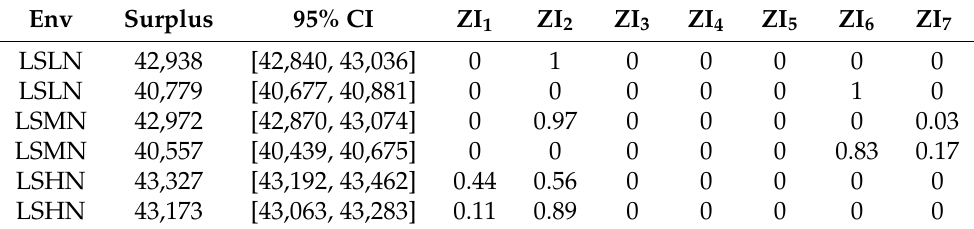
Table A10. Equilibria for games where agents are restricted to ZI strategies, N = 65, calculated from the five-player DPR approximation. Each row of the table describes one equilibrium found with its corresponding surplus and the equilibrium mixture probabilities of strategies